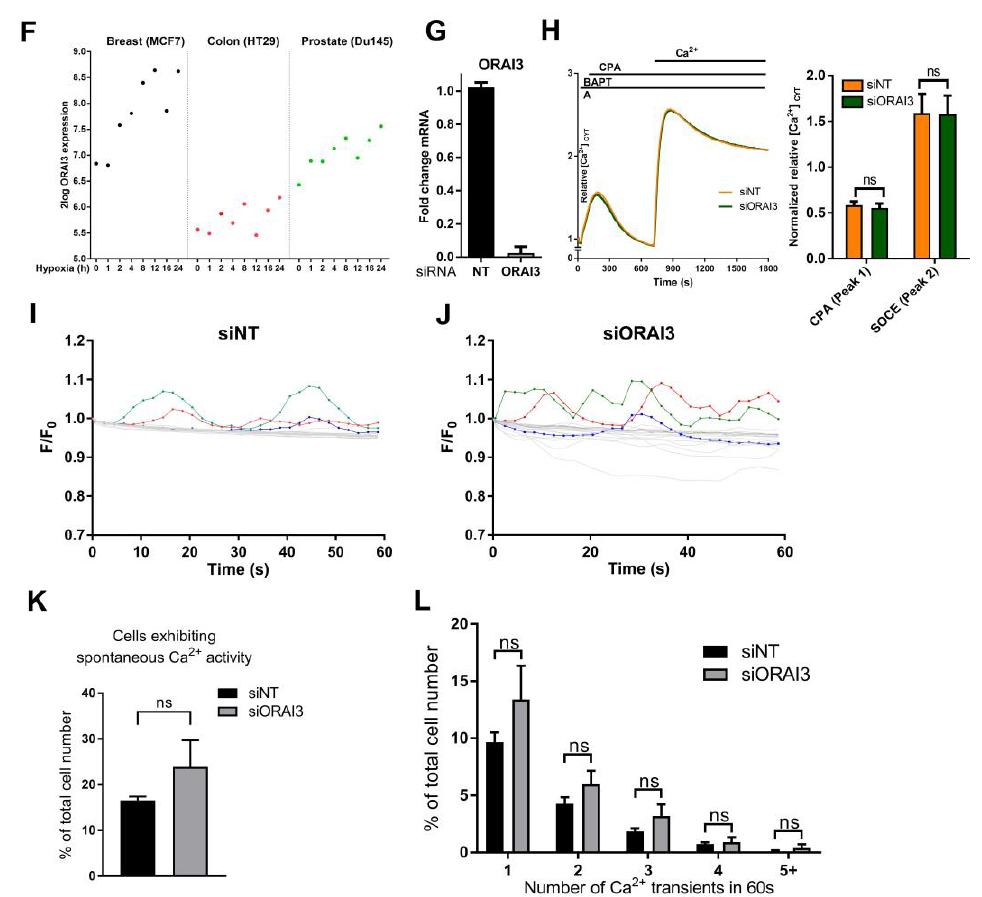
Figure 2. Hypoxia induces ORAI3 expression. ( A ) ORAI3 expression after EGF treatment (24 h, 50 ng/mL) treatment in MDA-MB-468 cells ( B ) mRNA expression of ORAI1 , ORAI2 and ORAI3 after hypoxia (24 h, 1% O 2 ) in MDA-MB-468 breast cancer cells compared to cells maintained in normoxia. ( C ) Induction of ORAI3 expression after hypoxia (24 h) in HCC1569, ( D ) MDA-MB-231 and ( E ) PMC42LA breast cancer cells. ( F ) Assessment of ORAI3 expression in breast (MCF7), colon (HT29) and prostate (Du145) after exposure of cells to normoxia (time-point 0 h) and different times of severe hypoxia (0% O 2 for 1, 2, 4, 8, 12, 16 and 24 h, respectively) extracted from the publicly available data [47] using the R2 genomics analysis platform. ( G ) confirmation of siRNA-mediated Orai3 silencing and ( H ) FLIPR traces (left) and quantification (right) of the mean [Ca 2+ ] CYT levels during store-operated Ca 2+ entry with ORAI3 silencing (siORAI3) and non-targeting siRNA control (siNT) in MDA-MB-468 cells exposed to 48 h hypoxia. ( I ) Spontaneous Ca 2+ transients in MDA-MB-468 cells expressing GCaMP6m following ORAI3 silencing (siORAI3) and 48 h exposure to hypoxia. Ca 2+ transients in 20 individual cells unbiasedly selected from a single well following silencing of non-targeted siRNA control ( I ), or ORAI3 ( J ). Highlighted lines represent examples of cells exhibiting spontaneous Ca 2+ activity. ( K ) Percentage of cells exhibiting spontaneous Ca 2+ activity. ( L ) Stratification of cells by number of Ca 2+ transients in 60 s. ns = not significant ( p ≥ 0.05), * p < 0.05, ** p < 0.01, *** p < 0.001 (unpaired t-test), n = 3, mean ±